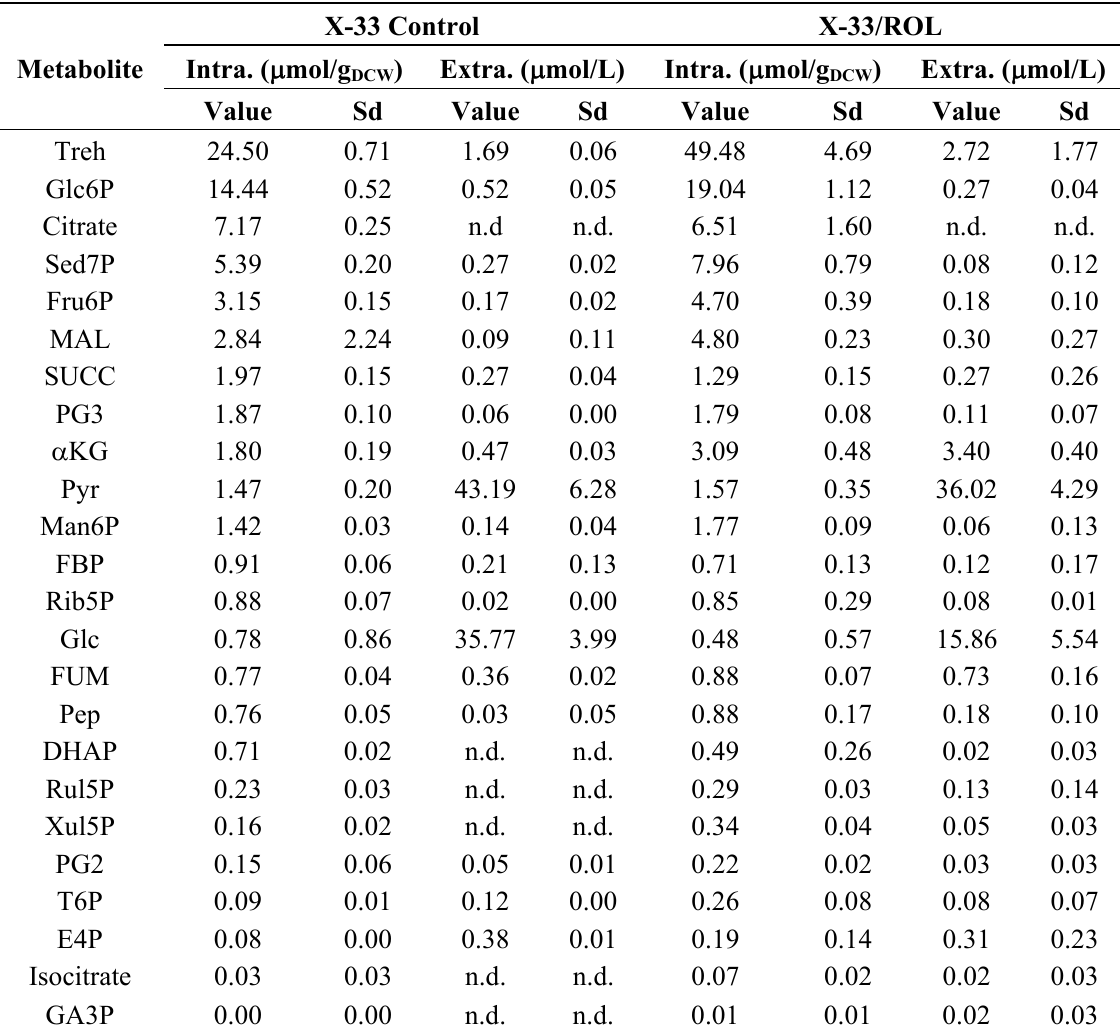
Table 3. Intra and extracellular metabolite concentrations in P. pastoris cells growing on glucose/methanol. Intracellular concentrations (Intra.) of metabolites pools are given in  mol/g Extracellular concentrations (Extra.) of metabolites are given in 